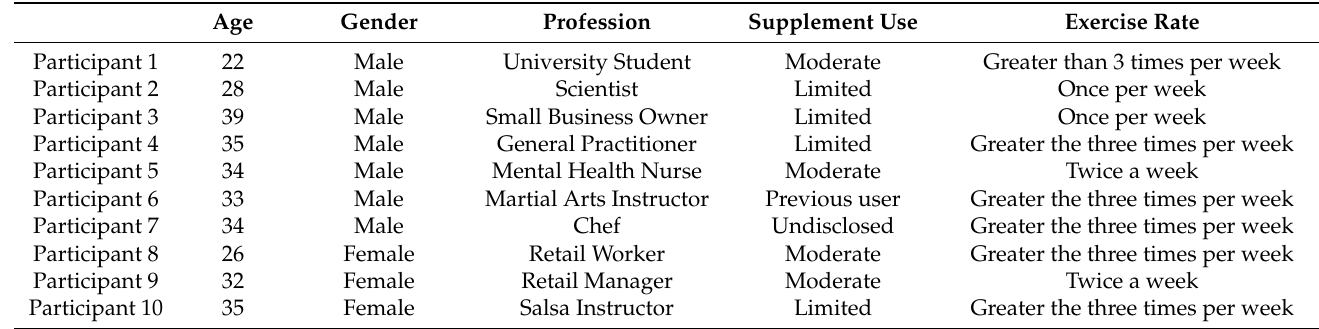
Table 1. Participant